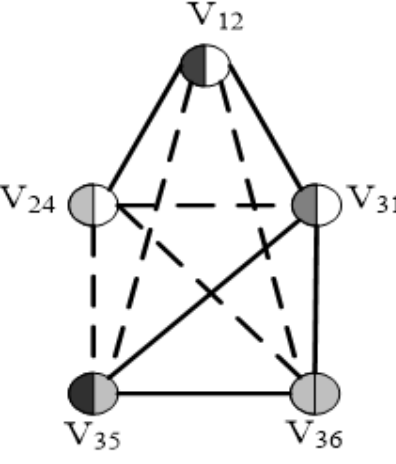
Figure 5. Graph vertex double coloring.